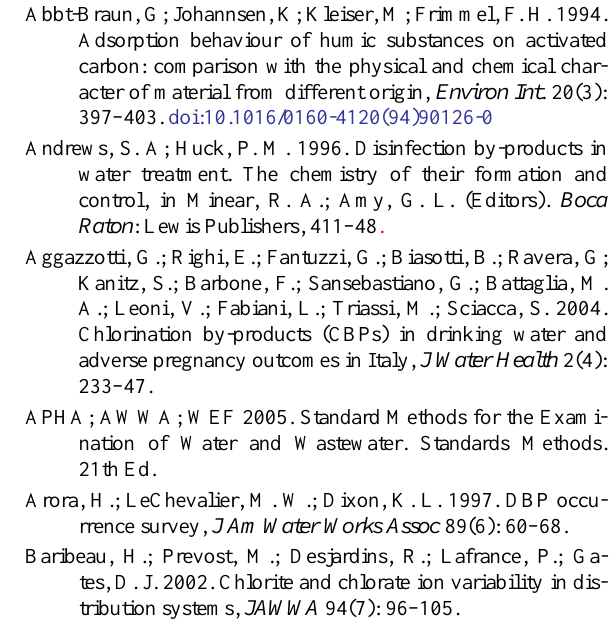
Fig. 5a. THMs (sum) removal as a function of bed volumes